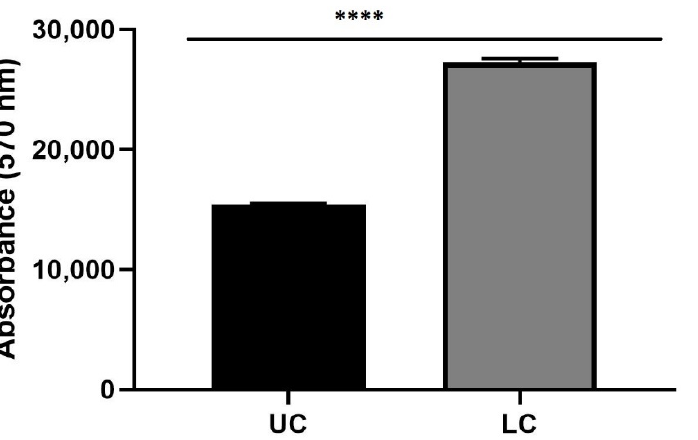
Figure 9. Spectrofluorometric analysis of rhodaminated PACAP (gH625-lipoPACAP-Rho) delivery across a BBB dynamic in vitro model (LB2) with bEnd.3 in the upper chamber and 3D SH-SY5Y/RA in the lower chamber. Functionalized liposome was loaded with PACAP-Rho and injected in the upper flow. The passage beyond the endothelial cell layer were then evaluated by sampling downstream the upper chamber (UC) and the lower chamber (LC), respectively. The graph shows the means ± SEM of three experiments. Statistical analysis was performed through the analysis of Mann–Whitney test. The differences were considered significant between gH625-lipoPACAP-Rho UC and gH625-lipoPACAP-Rho LC. **** p < 0.001. In another one, LB2 was in the upper chamber bEnd.3 cells, seeded on the porous membrane and in the lower chamber 3D SH-SY5Y/RA, treated with 1.5 mM MPP + (Figure 10).